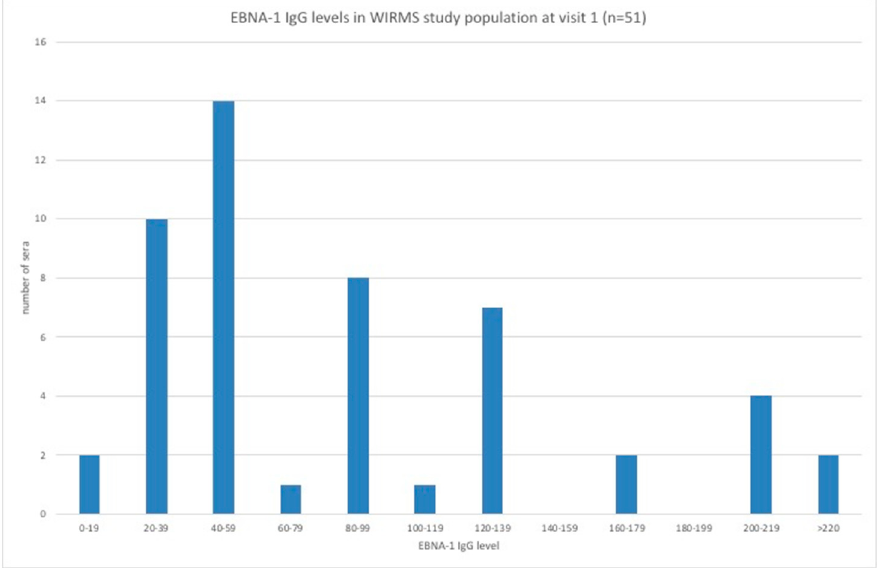
Figure 5. Distribution of EBNA-1 IgG levels in PwMS at baseline.